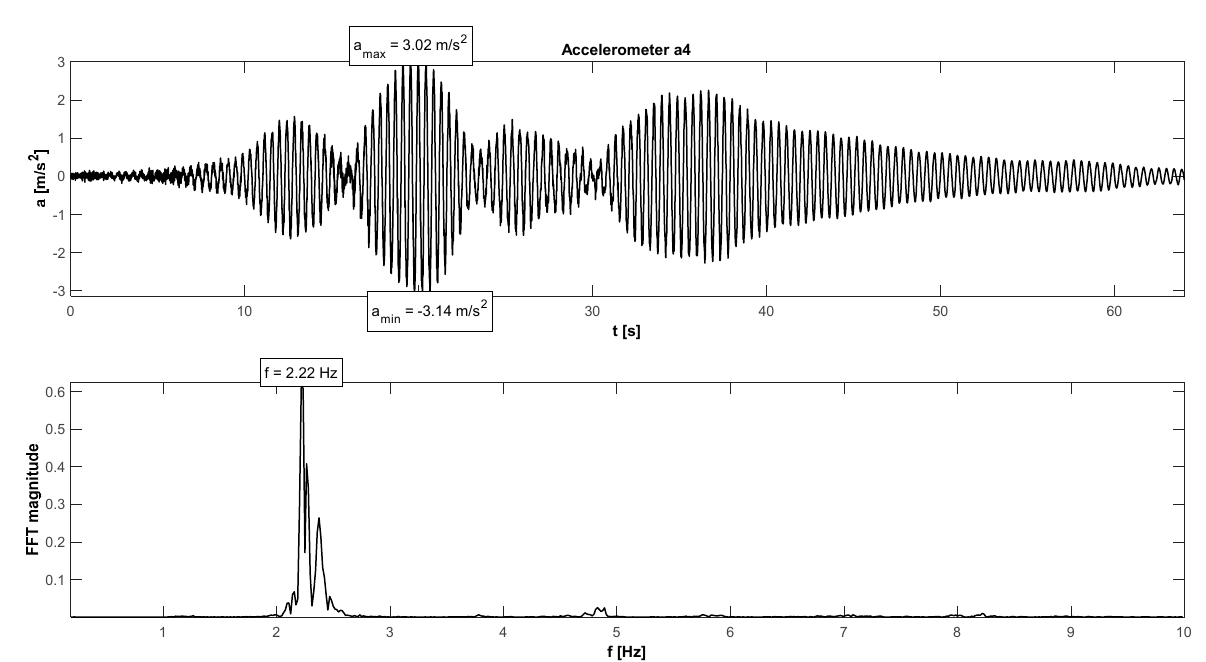
Figure 18. Signal of vertical vibrations in the time and frequency domain registered for the syn ‐ chronized running of 12 people. Table 4. Values of extreme accelerations of the deck.